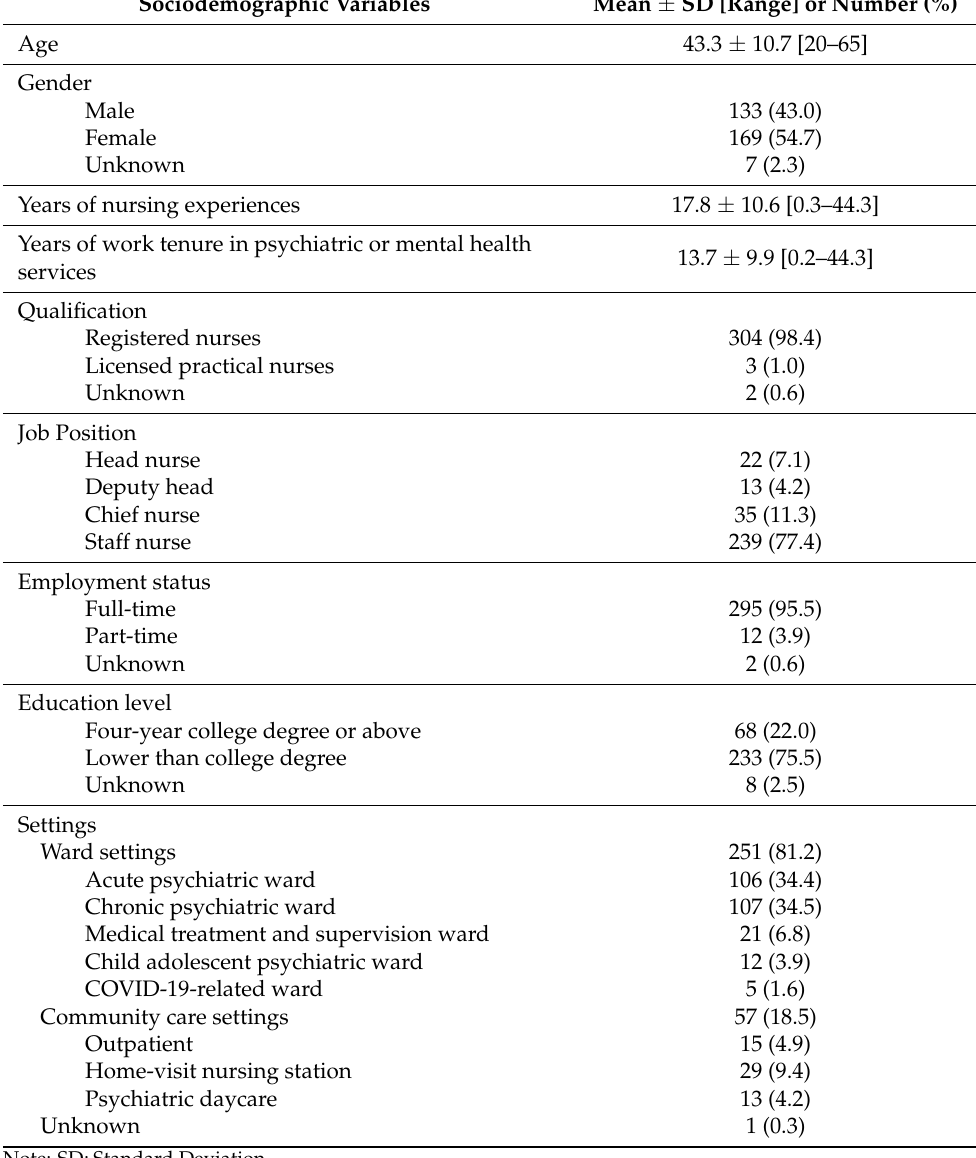
Table 1. Demographics of the participants ( n =